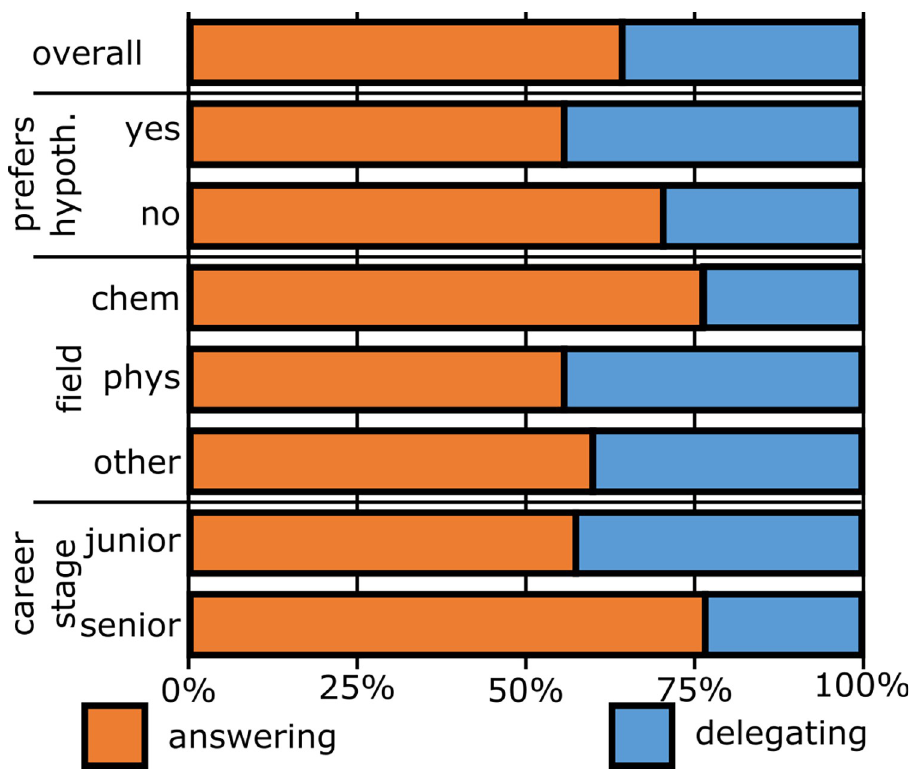
Fig 2. Controversy profiles frequency. Prevalence of the answering (orange) and delegating (blue) controversy profiles, when segmenting the sample by discipline, hypothesis preference, and career stage of the researchers (n = 45).